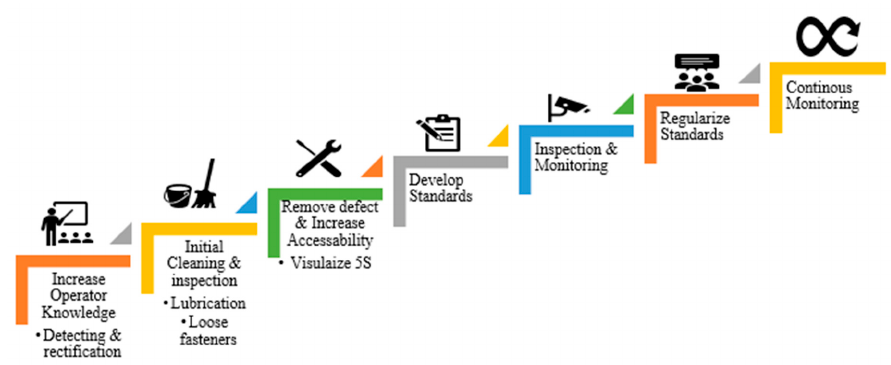
Figure 12. Autonomous maintenance procedure.